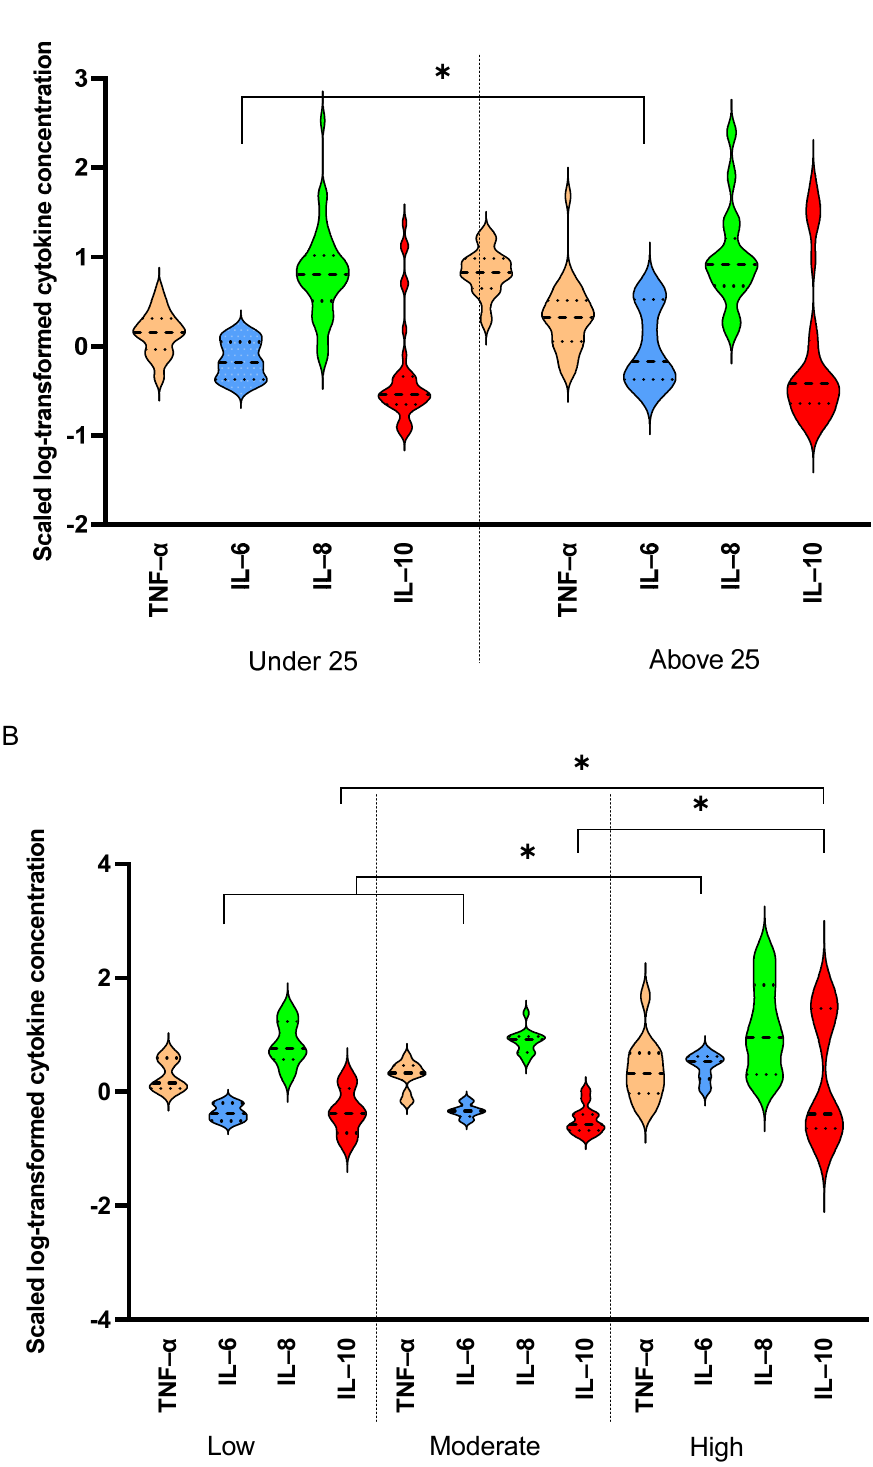
Figure 2. Comparing levels of serum cytokines between age and sport intensity groups. IL-8 and IL-10 were compared between younger (less than 25 years old, n = 45) and older (more than 25 years old, n = 35) elite athletes ( A ) in different sport intensities (low, n = 18, moderate, n = 31 and high, n = 31) ( B ). ANOVA was used to compare cytokine levels in different age and sport intensity groups. Data are presented as median and IQR. p * <0.05.